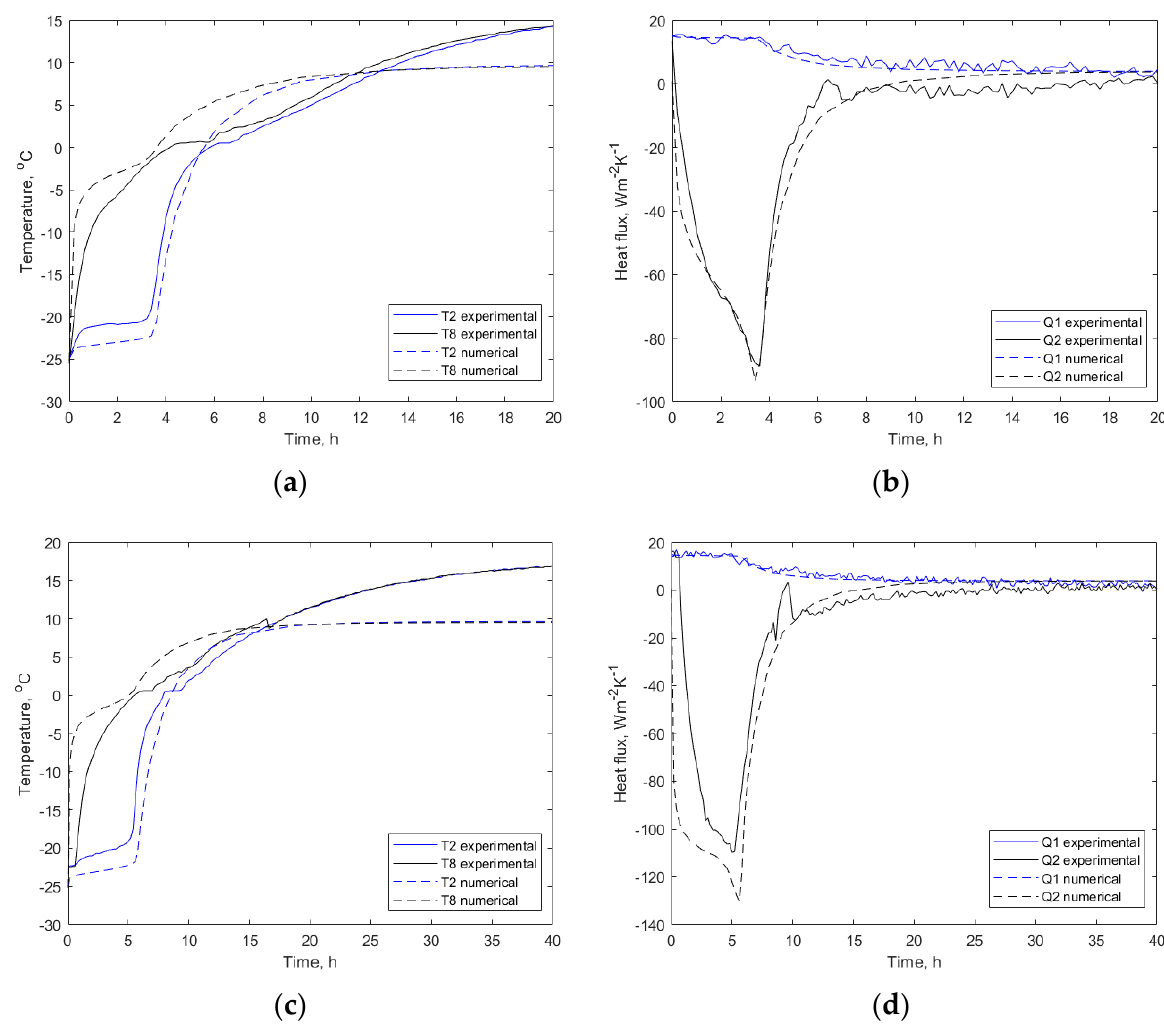
Figure 9. ( a ) Comparison of the temperature changes at the T2 and T8 measurement points in the numerical modeling with the results of experiments for a wall with a 6 mm PCM layer; ( b ) Comparison of the heat flow flux changes at Q1 and Q2 measurement points in the numerical modeling with the results of experiments for a wall with a 6 mm PCM layer; ( c ) Comparison of the temperature changes at the T2 and T8 measurement points in the numerical modeling with the results of experiments for a wall with a 10 mm PCM layer; ( d ) Comparison of the heat flow flux changes at Q1 and Q2 measurement points in the numerical modeling with the results of experiments for a wall with a 10 mm PCM layer.